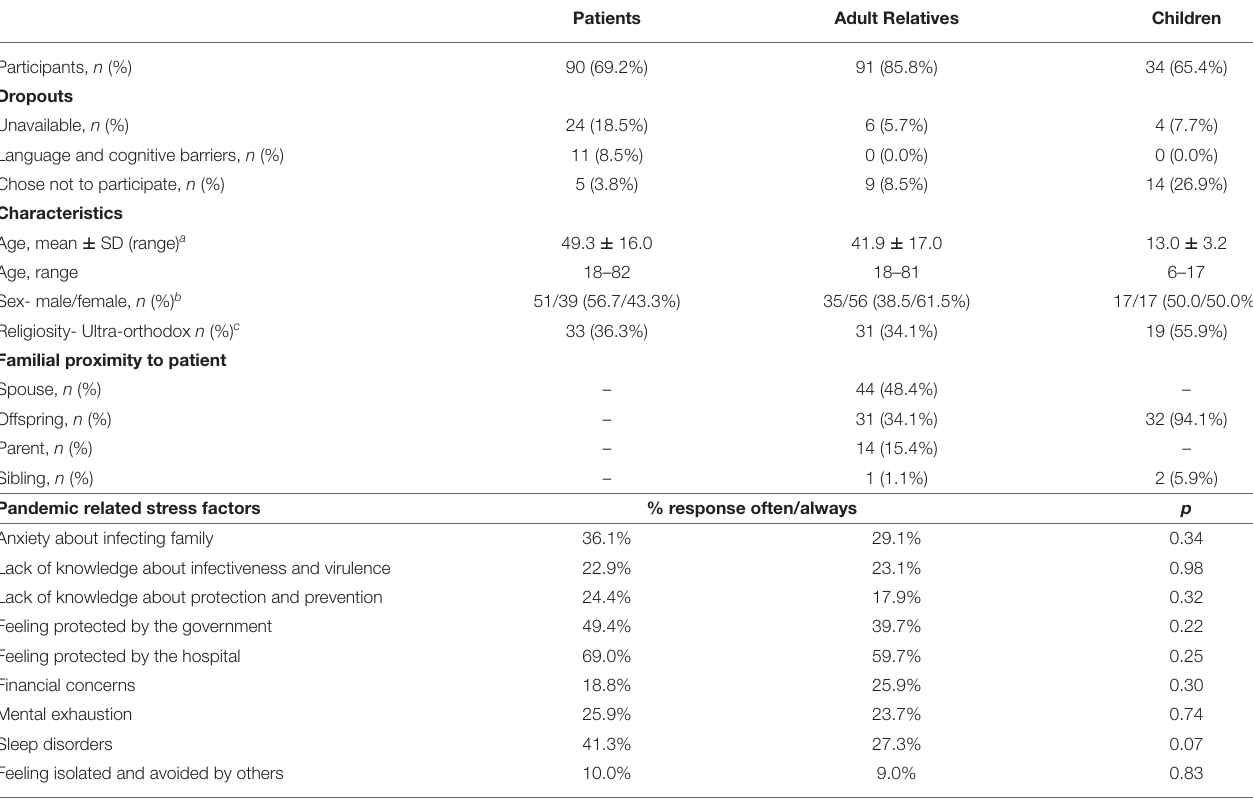
TABLE 1 | Sociodemographic properties and medical evaluation of study sample.